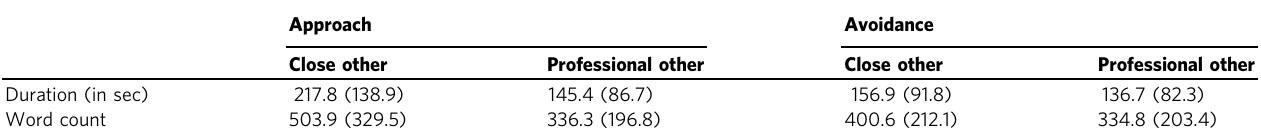
Table 2 Mean (SD) disclosure duration in seconds and word count.